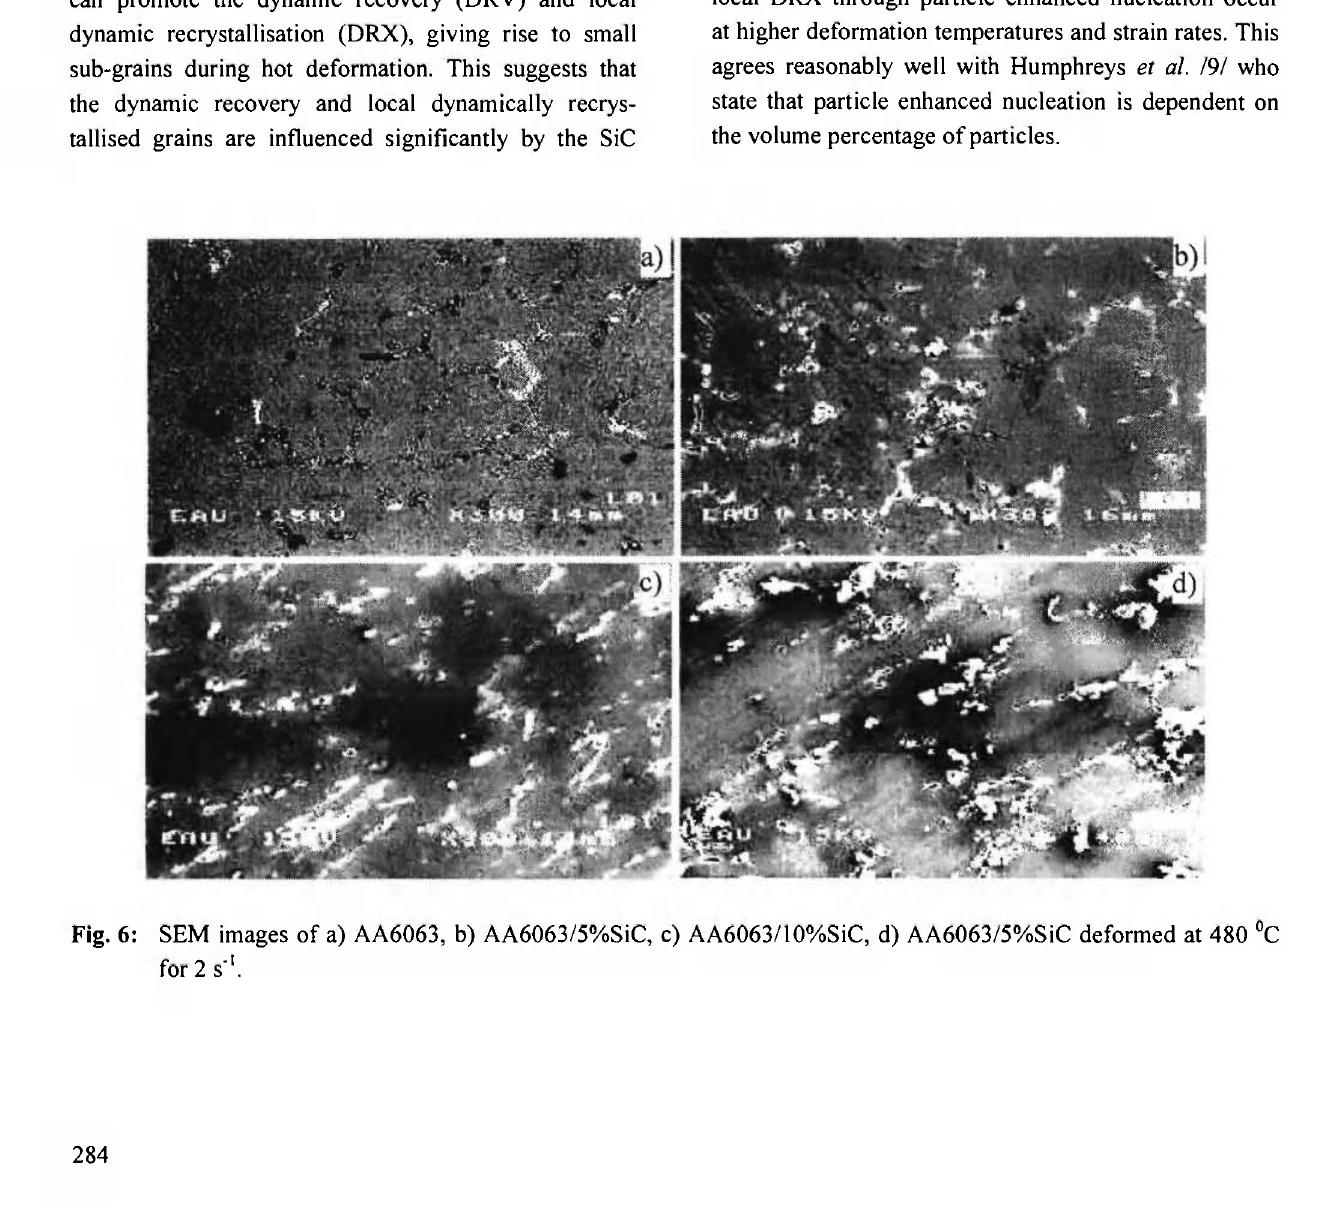
Fig. 6: SEM images of a) AA6063, b) AA6063/5%SiC, c) AA6063/10%SiC, d) AA6063/5%SiC deformed at 480 °C for 2 s" 1